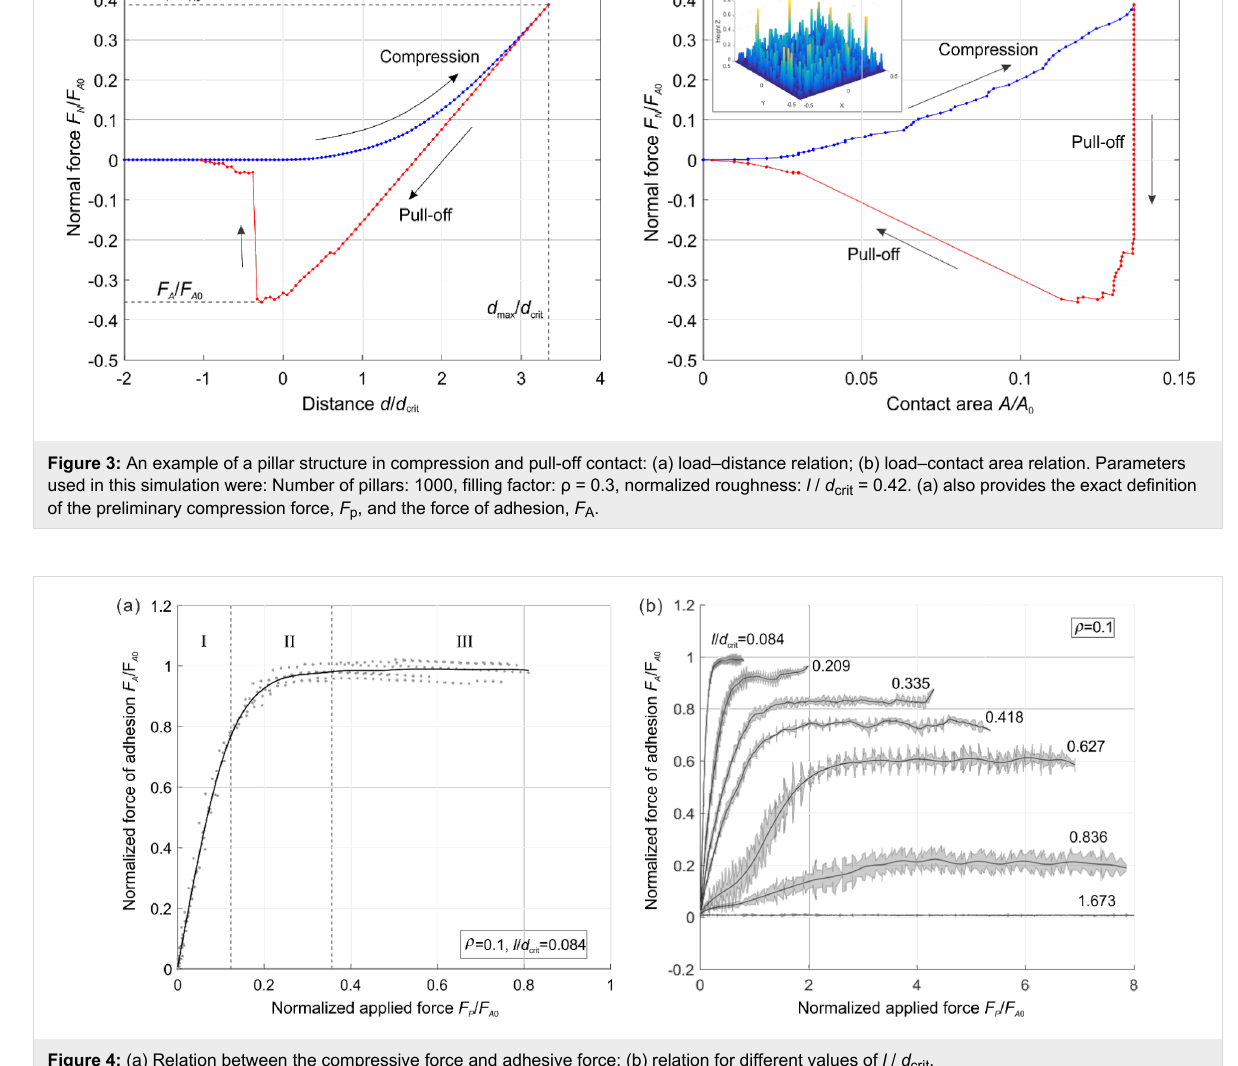
Figure 4: (a) Relation between the compressive force and adhesive force; (b) relation for different values of l / d crit .